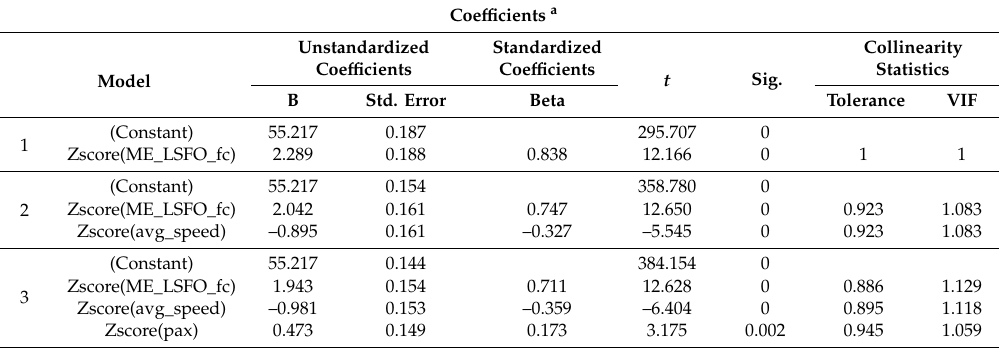
Table 7. Regression analysis outcomes from the stepwise